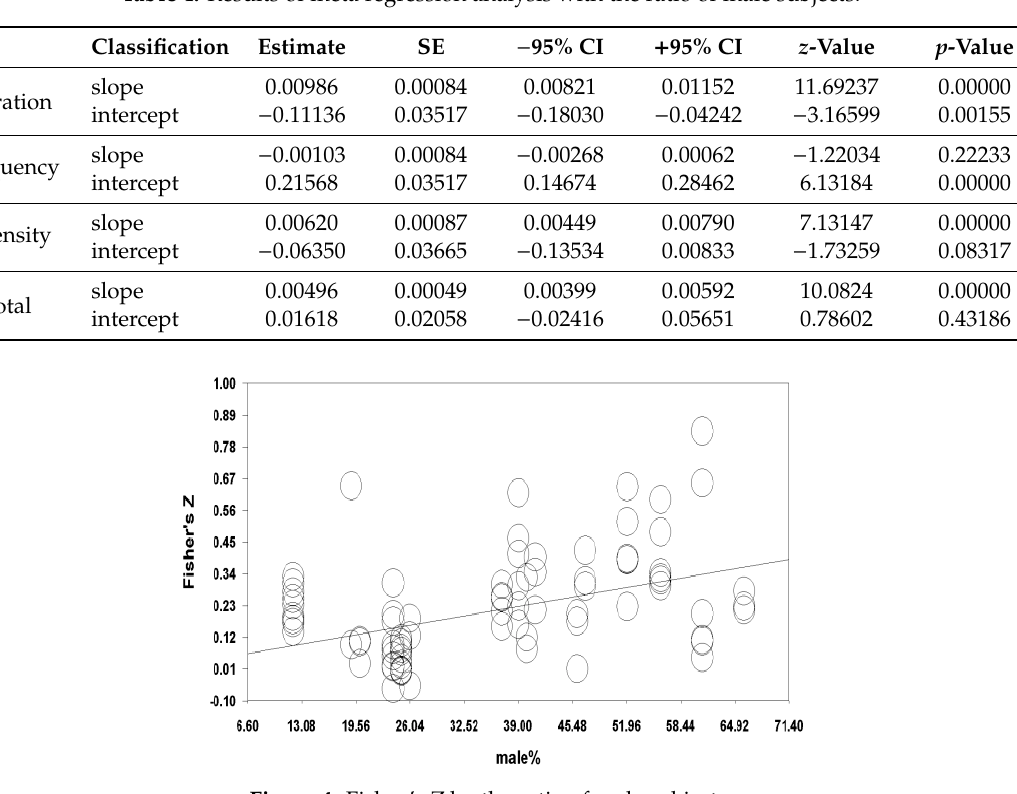
Table 4. Results of meta regression analysis with the ratio of male subjects.